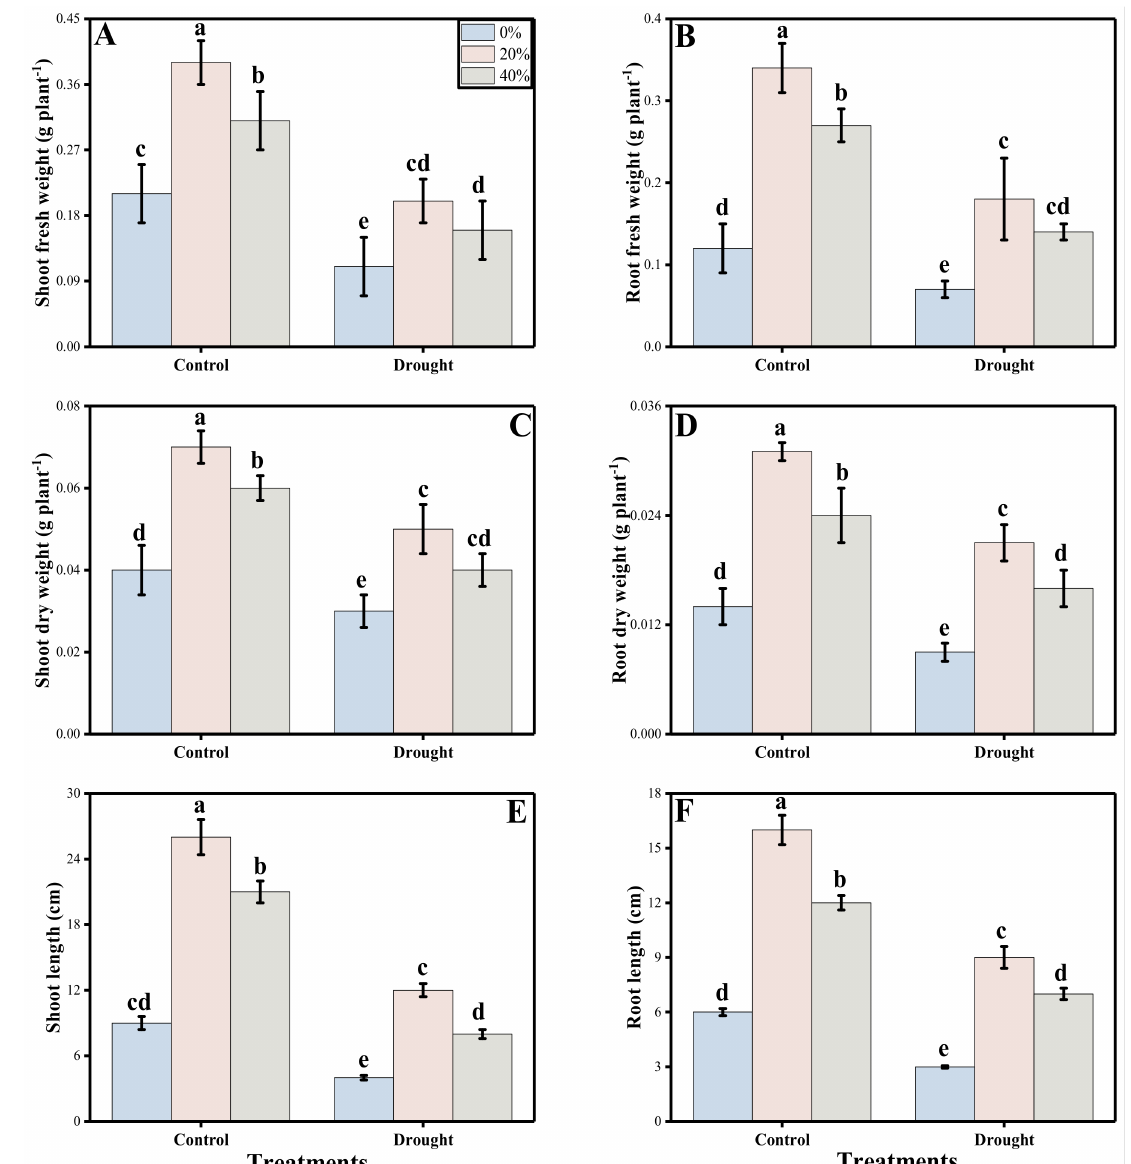
Figure 2. Effect of seed priming with Plantago ovata leaf extract on shoot fresh weight ( A ), root fresh weight ( B ), shoot dry weight ( C ), root dry weight ( D ), shoot length ( E ) and root length ( F ) under water stressed and non-stressed environments in maize cultivar Cimmyt − Pak. Means sharing similar letter(s) within a column for each parameter do not differ significantly at p < 0.05. Data in the figures are means of three repeats ( n = 3) of just one harvest of Zea mays plants ± standard deviation (SD). Different lowercase letters on the error bars indicate significant difference between the treatments. Different treatments ( P. ovata extract) used in this study are as follows: 0% (0% P. ovata extract), 20% (20% P. ovata extract) and 40% (40% P. ovata